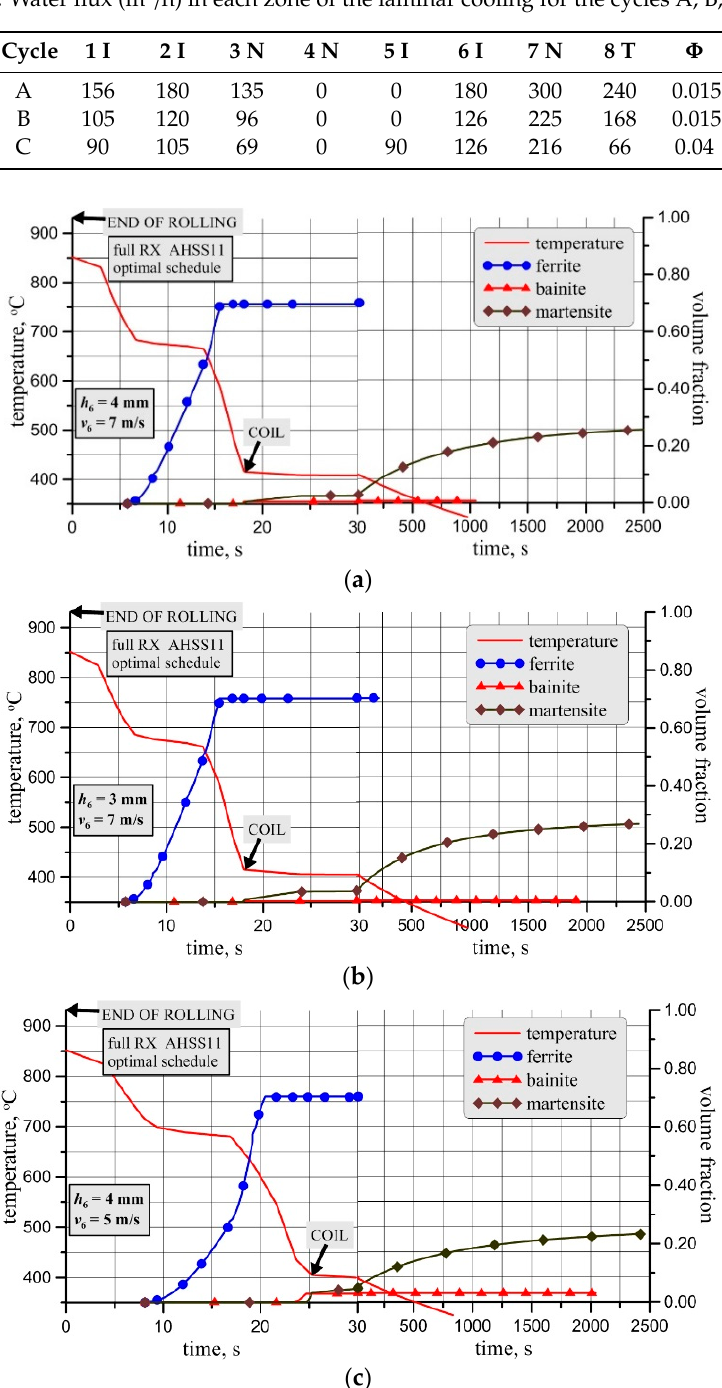
Figure 19. Temperatures and kinetics of transformations for the three optimal cooling schedules: ( a ) h 6 = 4 mm and v 6 = 7 m/s, ( b ) h 6 = 3 mm and v 6 = 7 m/s, ( c ) h 6 = 4 mm and v 6 = 5 m/s.